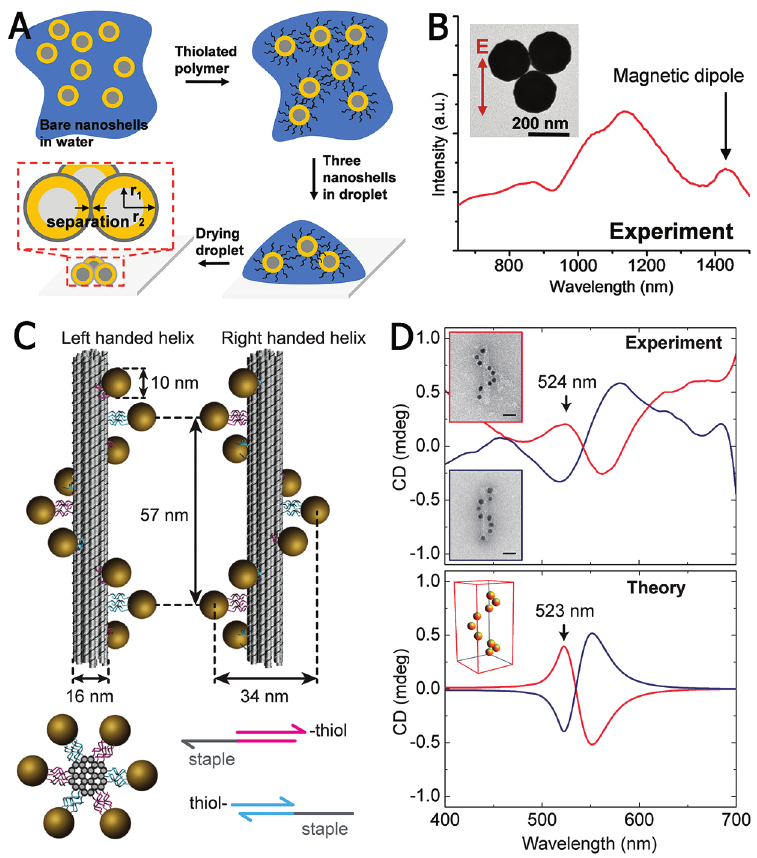
Figure 16 (A) Schematic illustration showing the procedures to assemble plasmonic clusters. (B) Scattering spectrum of a plasmonic trimer using cross-polarization method. The spectrum exhibits a clearly visible magnetic dipole resonance peak. The inset is the SEM image of the plasmonic trimer. (C) Schematic illustration showing DNA-guided self-assembly of plasmonic nanohelices. Left- and right-handed nanoheli- ces (diameter 34 nm, helical pitch 57 nm) are formed by nine gold nanoparticles each of diameter 10 nm that are attached to the surface of the DNA origami 24-helix bundles. (D) Experimental (top panel) and theoretical (bottom panel) circular dichroism spectra of the self- assembled gold nanohelices. The spectra of left-handed (red lines) and right-handed (blue lines) helices of nine gold nanoparticles show characteristic bisignate signatures. (A) and (B) are adopted from Ref. [208], and (C) and (D) are adopted from Ref. [211] with permissions,